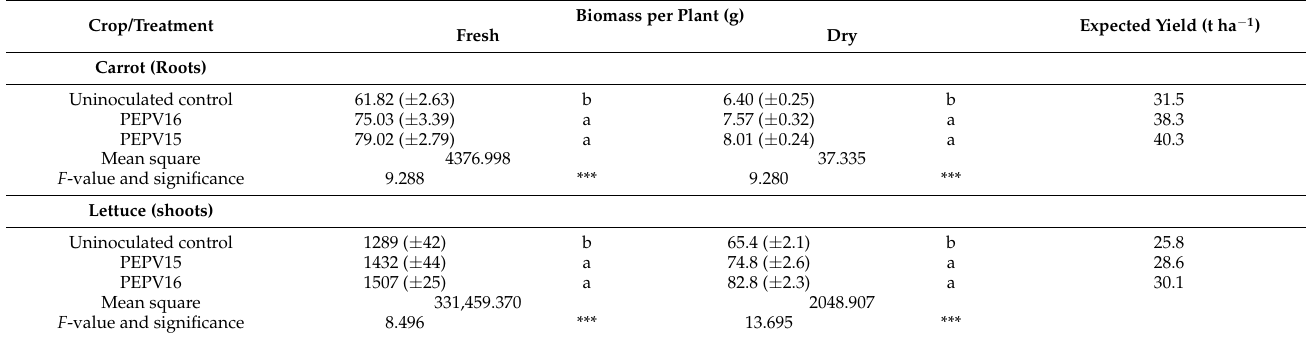
Table 4. Mean values and standard errors corresponding to the roots and shoots biomasses produced by carrot and lettuce crops, respectively, after the inoculation with the PEPV15 and PEPV16 strains and in the uninoculated controls in the field experiment. The values followed by the same letter did not significantly differ in the Tukey test. ANOVA was performed with blocks as a random factor and the treatment as a fixed factor ( p -value: *** p ≤ 0.001). Data refer to a single plant, and yield was calculated for an expected final density of 510,000 plants ha − 1 . Crop/Treatment Biomass per Plant (g) Expected Yield (t ha − 1 ) Fresh Dry Carrot (Roots) Uninoculated control